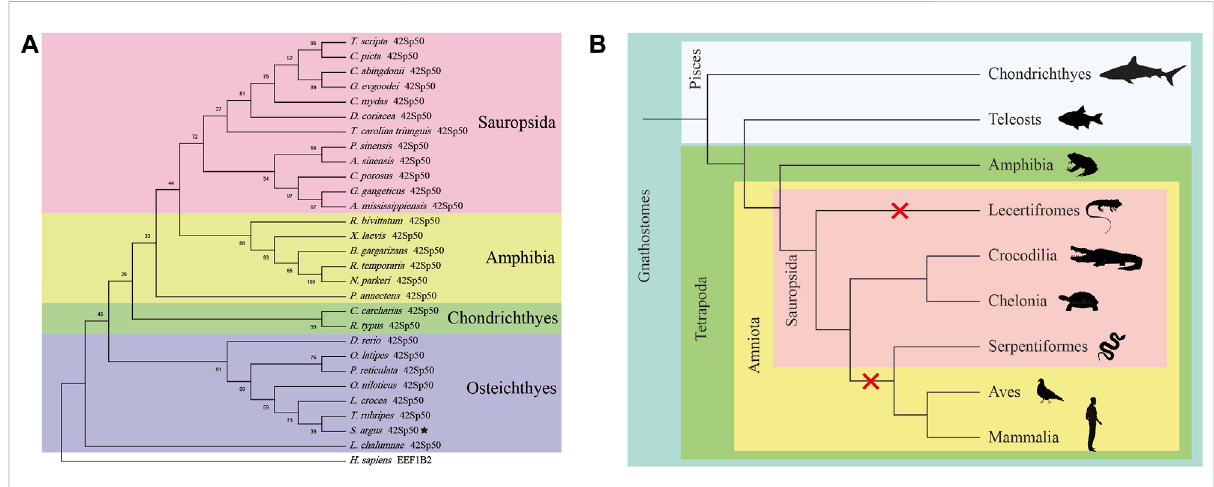
Phylogenetic analysis of 42Sp50 in vertebrates. (A) Phylogenetic tree of the 42Sp50 in selected vertebrate species. The tree was constructed usingMEGAXandtheNeighbor-joiningapproach.Bootstraptestingwasbased on500replicates. The 42Sp50 genesofspottedscat aredenoted